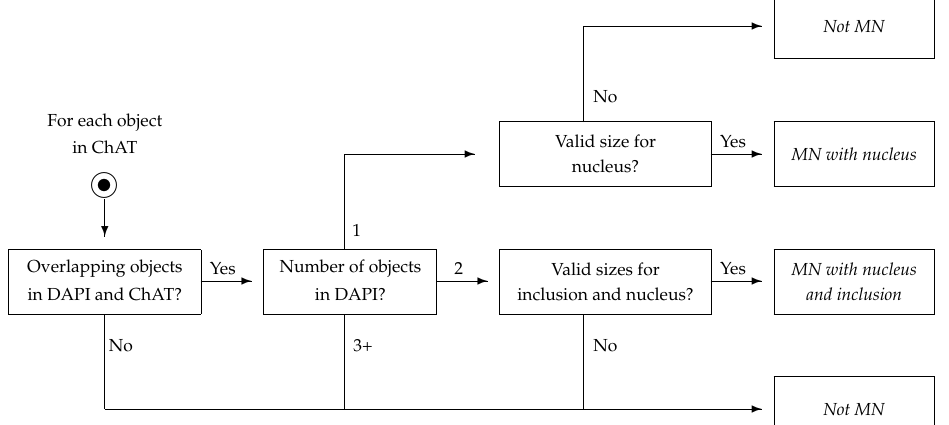
Figure 6. Schematic representation of the Labelling (LBL) phase for each object in MagNoLia . Boxes with slanted text represent final states, while all remaining boxes are decision